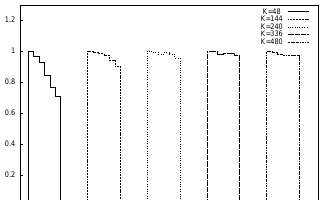
Figure 4. Results of the efficiency test for the McFadden problem. Data are grouped in five histograms. Each one represents the efficiency vs. the num- ber of processes involved in the compu- tation, for a fixed K